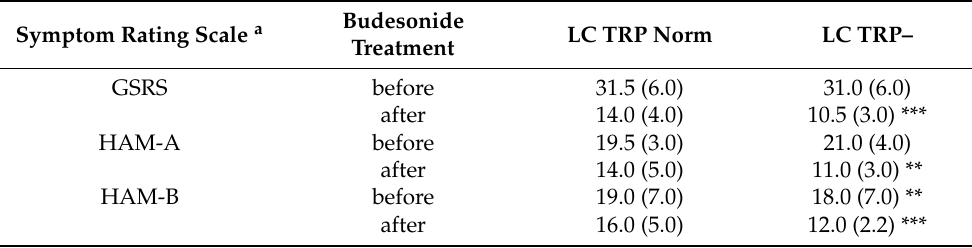
Table 3. Severity of gastrointestinal complaints and mental disturbances in lymphocytic colitis (LC) patients with normal and reduced dietary TRP content (TRP norm and TRP–, respectively; n = 30 in either group) before or after 8 weeks of budesonide treatment at 9 mg